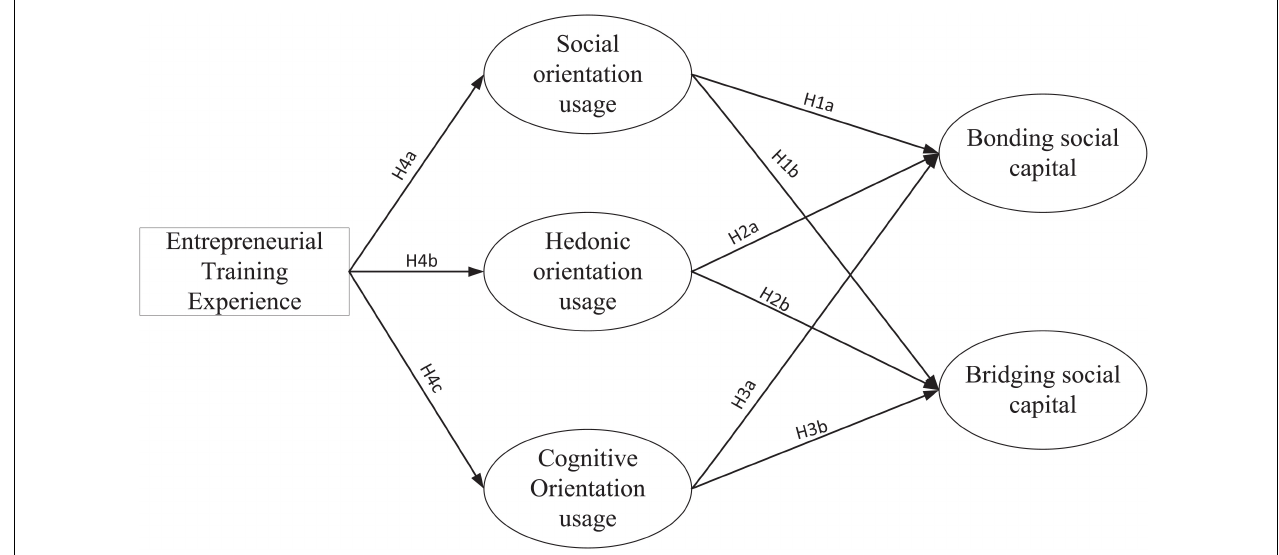
FIGURE 1 | Research model.